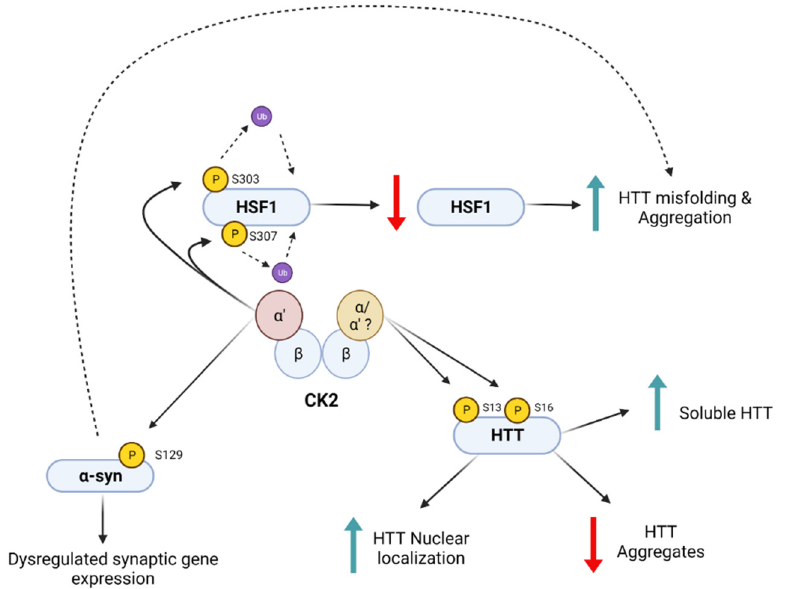
Figure 3. CK2 Targets in Huntington’s Disease. CK2 mediates the phosphorylation of several targets identified to be relevant to HD: HTT, HSF1, and a-syn. Gomez-Pastor et al. 2017 and Yu et al. 2022 [134,135] have identified the a’ subunit to be the primary catalytic subunit driving HSF1 and α -syn phosphorylation, respectively, although while evidence from Atwal et al. 2011 and Bowie et al. 2018 [71,98] support CK2 phosphorylating HTT the respective contributions of the alpha and alpha prime subunits, if any difference, have not been deciphered. Downstream effects, as summarized above, of α -syn and HSF1 phosphorylation have detrimental effects in HD, whereas downstream effects of HTT phosphorylation are beneficial. Created with BioRender.com (accessed 29 June 2022)